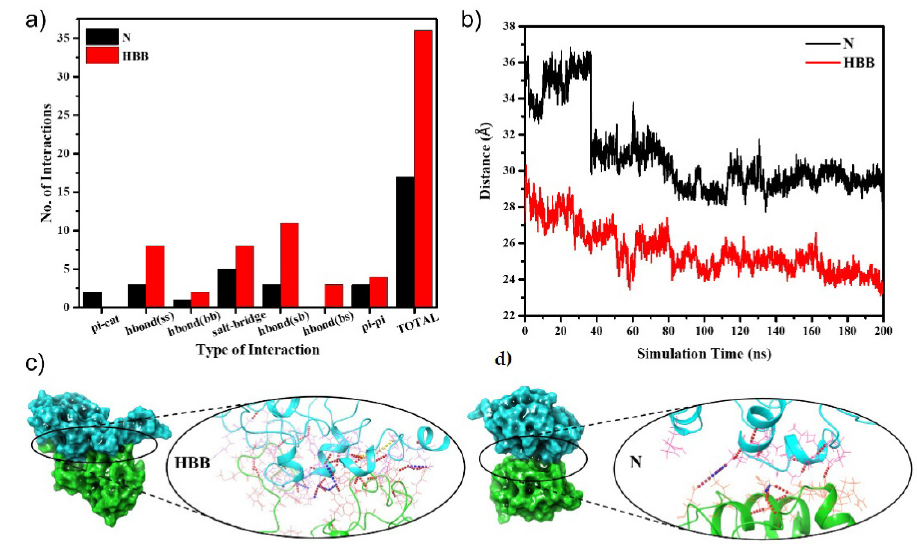
Figure 4. ( a ) Various kinds of interactions amidst the monomers N and HBB; ( b ) binding free energy of the docked proteins with the monomers N and HBB; ( c ) the total number of interactions in the dimers of the N and HBB systems; ( d ) a visual representation of the docked protein dimers in N and HBB indicating a more significant number of interactions in HBB as compared with N.